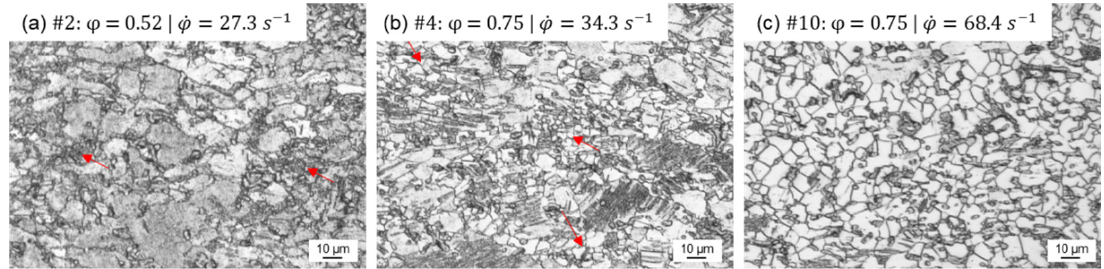
Figure 2. Optical micrographs of the as-rolled WZ73 magnesium alloy produced with different equivalent strain and equivalent strain rates: ( a ) sample #2, ( b ) sample #4 and ( c ) samples #10 (red arrows mark recrystallized areas in ( a , b )).